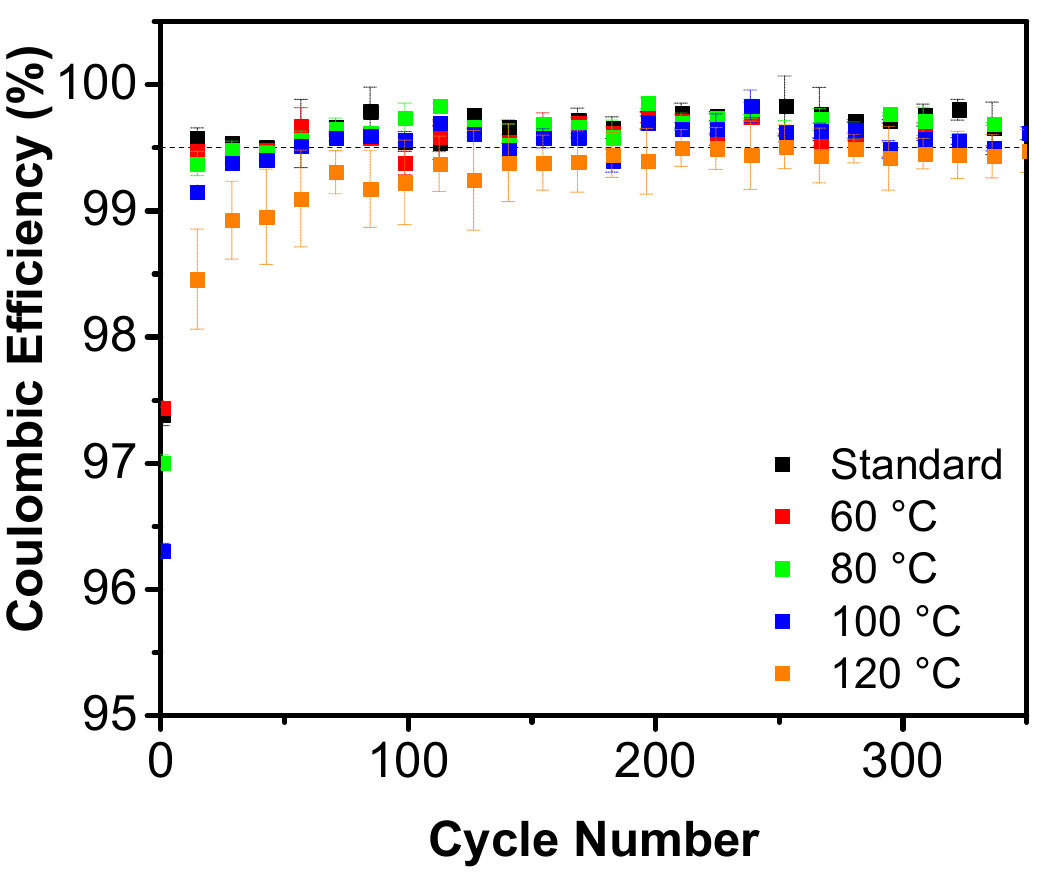
Figure 11. The mean value and standard deviation of coulombic efficiency of the synthesized CuHCF-based electrodes, annealed at different temperatures and galvanostatically cycled at 1C. The mean value and the standard deviations were calculated according to at least two different measurements of two different synthesis batches for each annealing temperature.